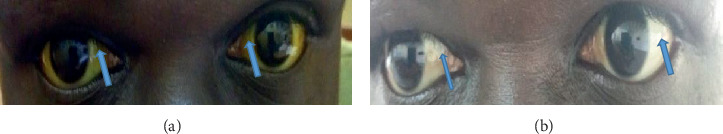
Participant with jaundiced eyes (a) and after 2 weeks of treatment (b).